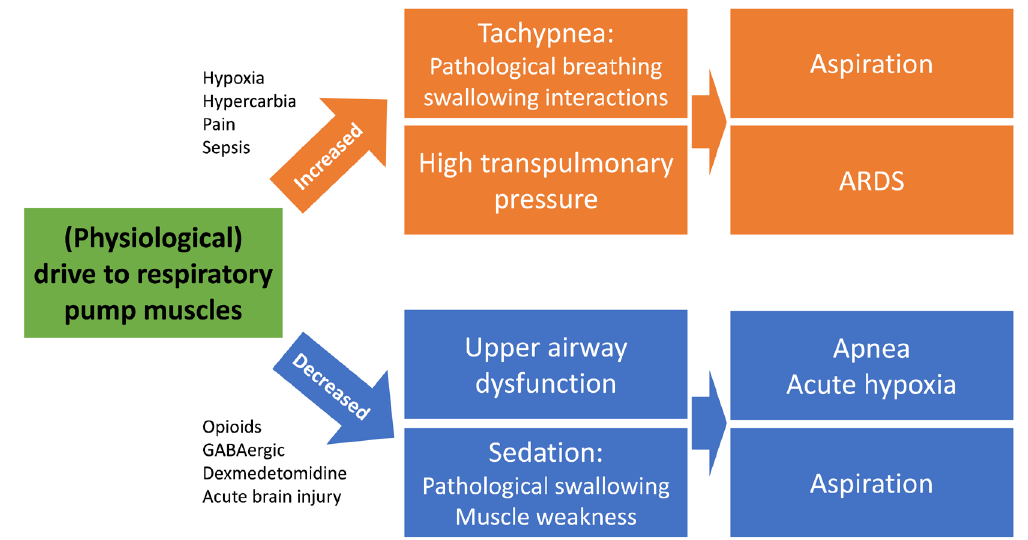
Figure 1. Effects of respiratory drive on perioperative respiratory complication risk. Changes in respiratory drive play a key role in the development of postoperative respiratory complications. Both increases and decreases in respiratory drive are potentially harmful and can affect the risk of aspiration. In addition, an increase in respiratory drive, for example during hypercapnic respiratory failure, can lead to high transpulmonary pressure during inspiration, which increases lung stress. Sedation commonly leads to upper airway dysfunction, resulting in insufficient respiration (hypopnea/apnea) but also affects the breathing–swallowing coordination and pharyngeal muscle strength, both of which contribute to pharyngeal dysfunction and increased risk of aspiration 12 . Supplementation of inhaled carbon dioxide was shown to reverse upper airway collapsibility induced by propofol 13 , but excessive hypercapnia increases the likelihood of pathological swallowing 14 . Thus, perioperative physicians need to balance their interventions to keep ventilator drive within normal limits. ARDS, acute respiratory distress